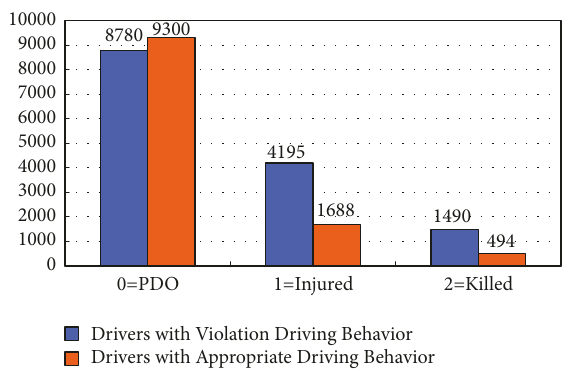
Figure 1: Highway-rail grade crossing accidents by driving behav-